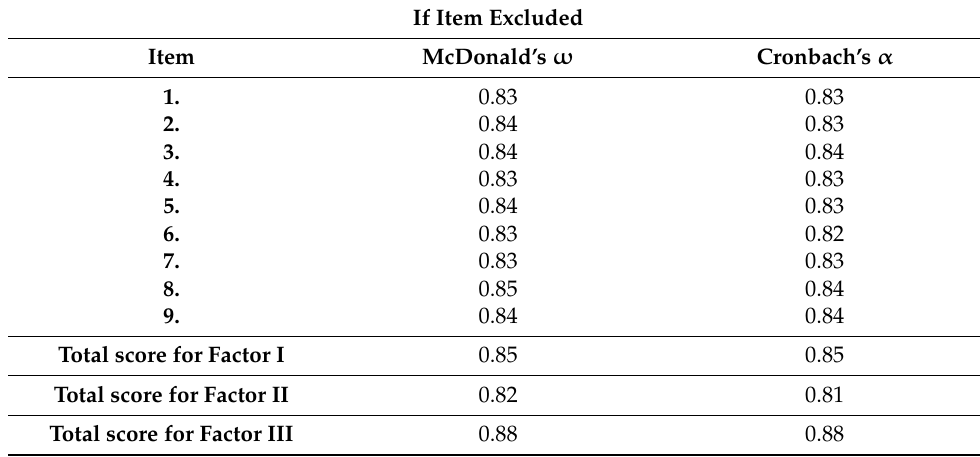
Table 3. Internal consistency of the nurses’ pandemic-related experiences